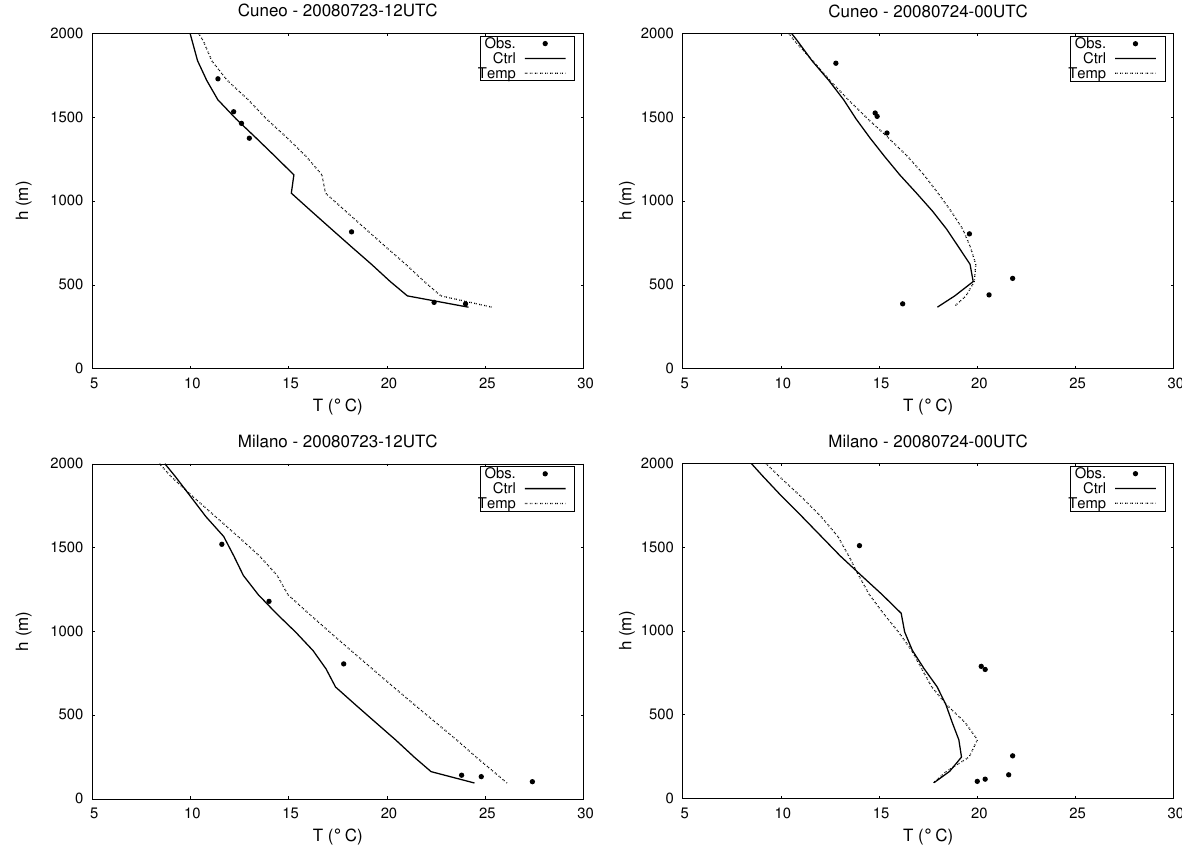
Fig. 17. Vertical temperature profile in Cuneo (above) and Milano (below), at +12h (left) and +24h (right) for the July 2008 case. The dots represent the observations, the continuous line represents the Ctrl run and the dotted line represents the Temp run. Table 3. Horizontal mean of 12-hourly sums of analysis increments as a function of pressure for the four test